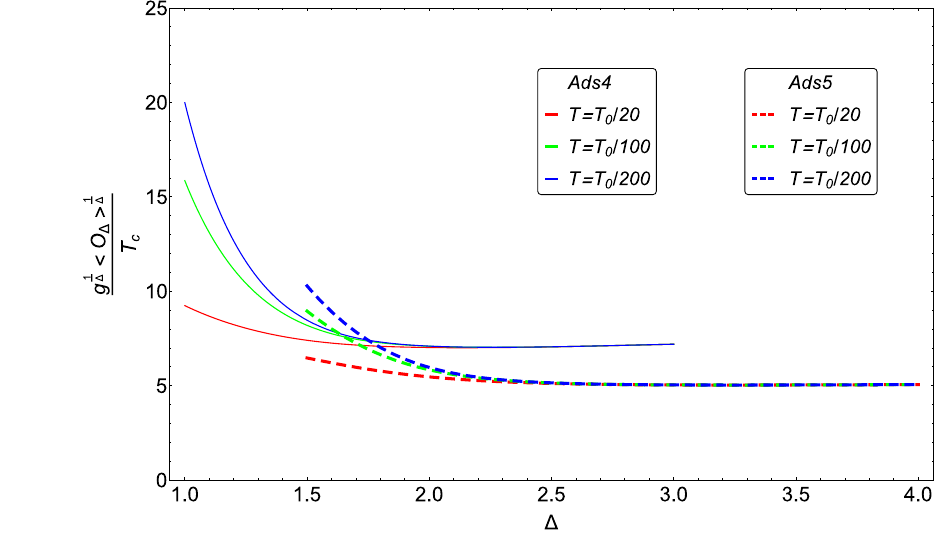
Fig. 12 g 1 (cid:2) (cid:3) O (cid:2) (cid:4) T = 0. Here, T 0 = ( g ρ)